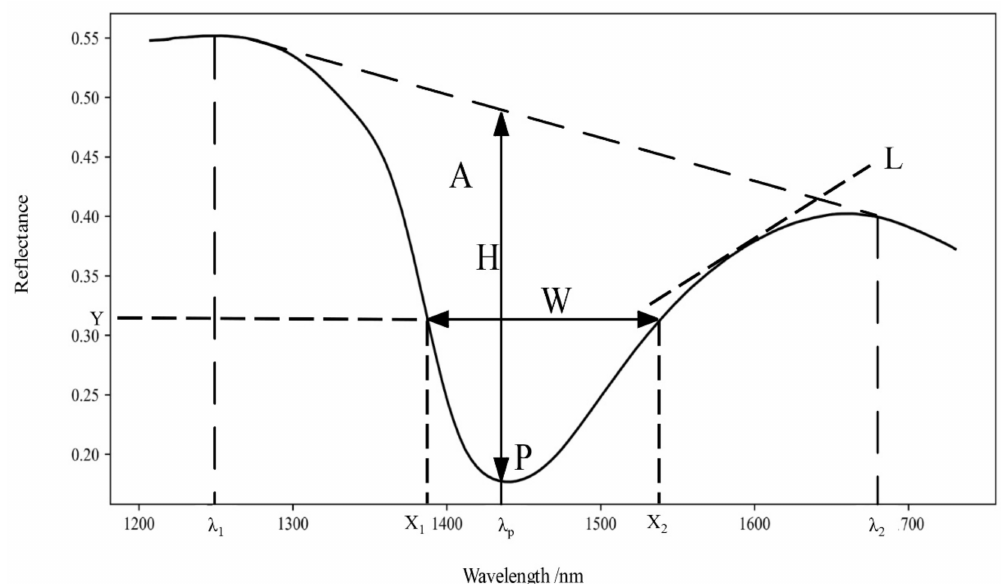
Figure 2. A part of lemon leaf reflectance (1200–1700 nm) and definitions of absorption features (where H means absorption depth, W represents the full-width half maximum, the absorption position (P) marks the wavelength at the deepest absorption in the region of visible wavelength, λ P is the corresponding wavelength, A is the area left area of the absorption center, L is tangent line, X 1 and X 2 are the wavelengths of left and right shoulder at the position of the full-width half maximum, and Y is the corresponding reflectance of X 1 and X 2